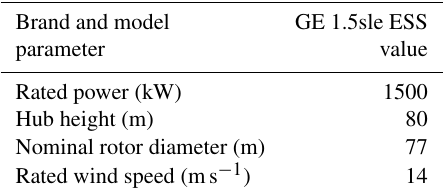
Table 1. Test turbine